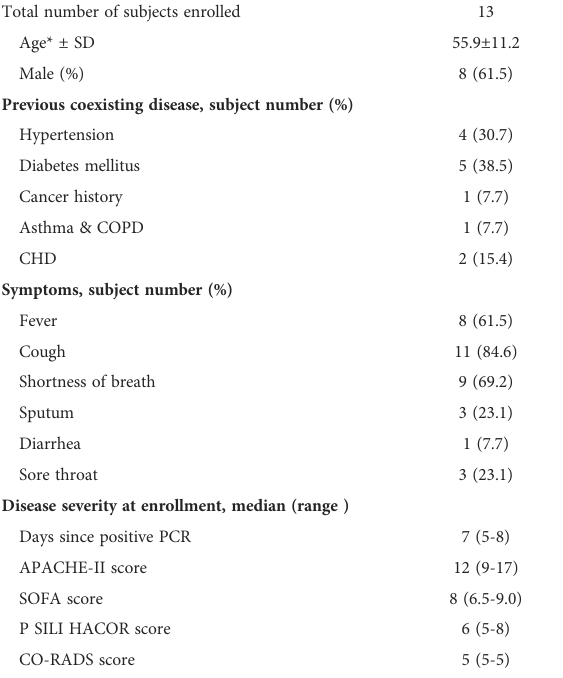
Table 1B Clinical follow up & fi nal outcomes after chipEXO TM